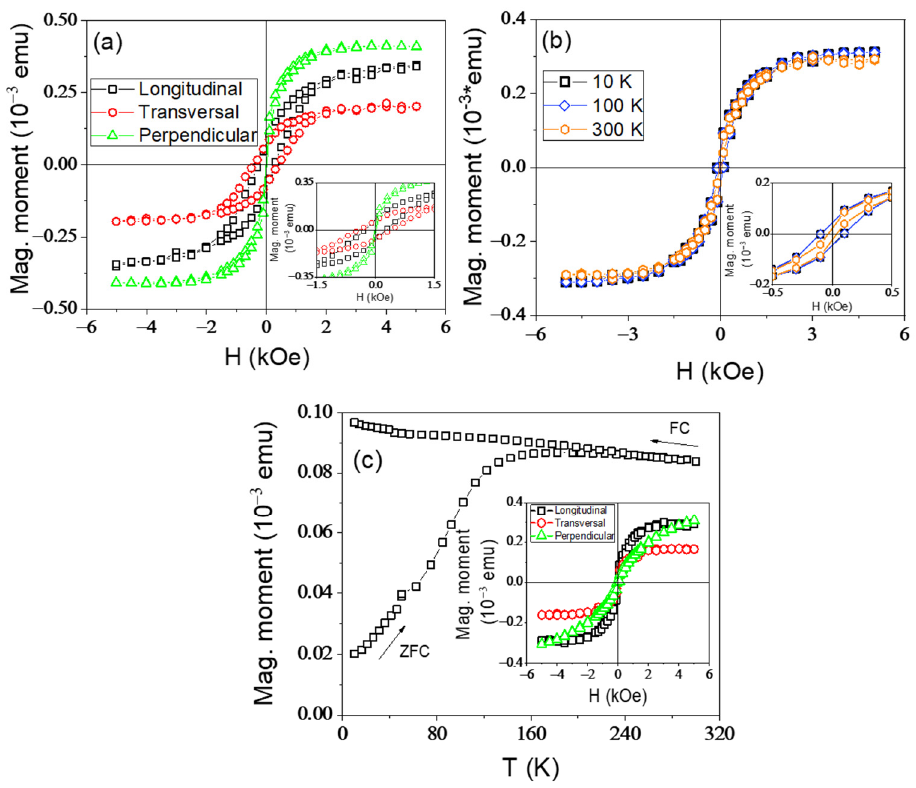
Figure 3. Hysteresis loops of the Fe nanostructured system collected at 10 K in longitudinal, transversal, and perpendicular geometry ( a ); hysteresis loops as a function of temperature in longitudinal geometry ( b ). Insets present an enlarged image of the hysteresis loops around the origin. ZFC-FC curves collected with 200 Oe applied field in longitudinal geometry. Inset shows the hysteresis loops collected at 300 K in different geometries ( c ).